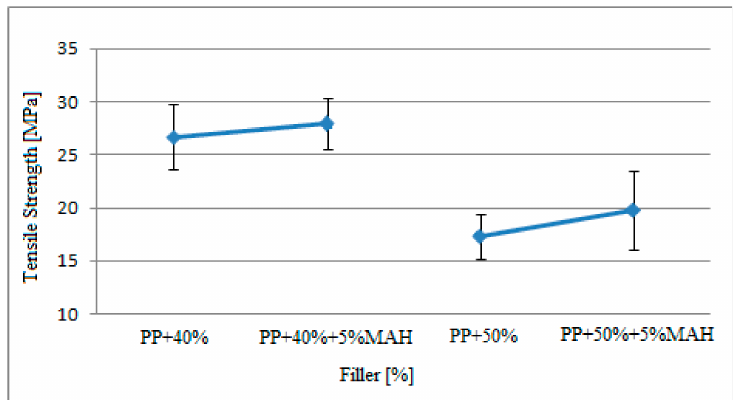
Figure 5. The variation in tensile stress of polypropylene matrix samples based on filler and maleic anhydride (MAH) content after gamma radiation